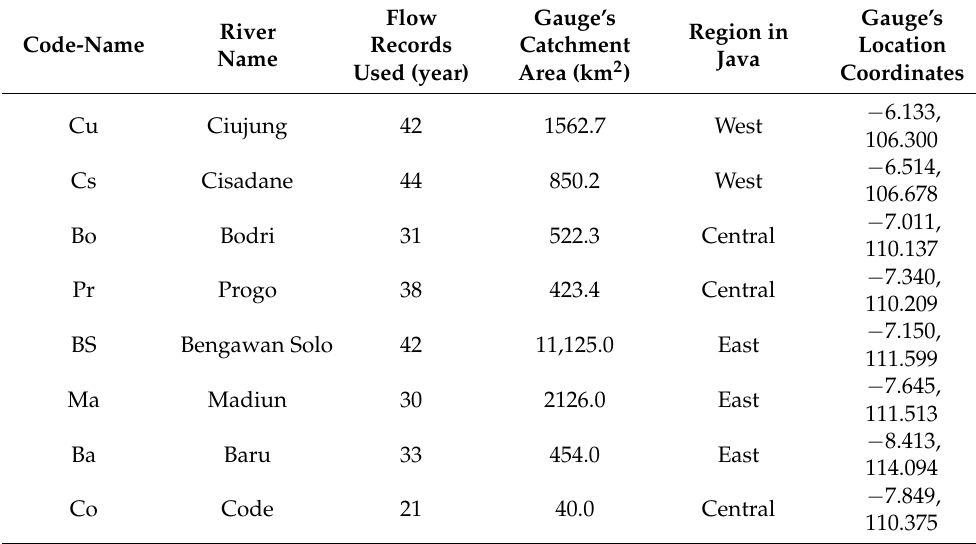
Table 1. Profiles of the streamflow gauge